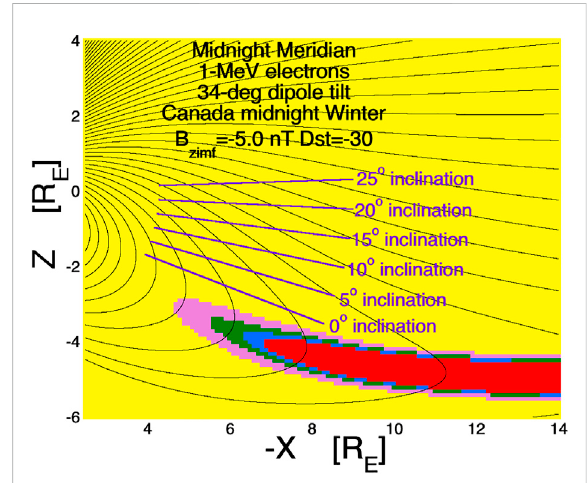
FIGURE 4 Magnetic- fi eld lines in the nightside magnetosphere in the noon-midnight meridian are drawn as the black curves using the T96 magnetic- fi eld model. The dipole equator on the nightside is tipped 34 ° southward, representing the dipole tilt at the December equinox when Canada is at local midnight. At this time the Earth ’ s spin axis is tilted away from the Sun by 23 ° and the dipole is tilted a further 11 ° . In the plot Z is the north-south direction and X is the Sun-Earth direction. The approximate orbital planes ofa4.3R E -by-9R E MIO orbitaredrawn asthelinesegments labeledforthevariousorbitinclinations.Thecoloredshadingisthe calculated eastward shift of the local atmospheric loss cone for 1- MeV electrons based on the local magnetic- fi eld strength and the local radius of curvature of the magnetic fi eld lines calculated in the T96 magnetic- fi eld model. The color scheme is yellow (shift < 0.5 ° ), pink (shift 0.5 ° – 1 ° ), green (shift 1 ° – 1.5 ° ), blue (shift 1.5 ° – 2 ° ), and red (shift > 2 ° ). Essentially, it is prudent to operate the MIO Accelerator only in the yellow shaded